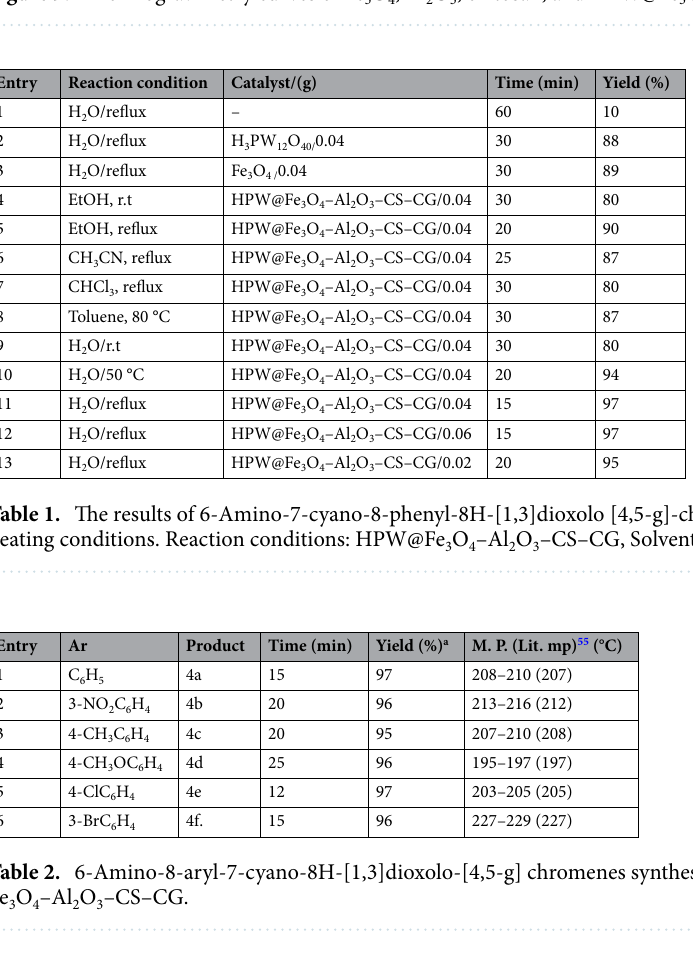
Figure 9. Thermogravimetry curves of Fe 3 O 4 , Al 2 O 3 , chitosan, and HPW@Fe 3 O 4 –Al 2 O 3 –CS–CG.